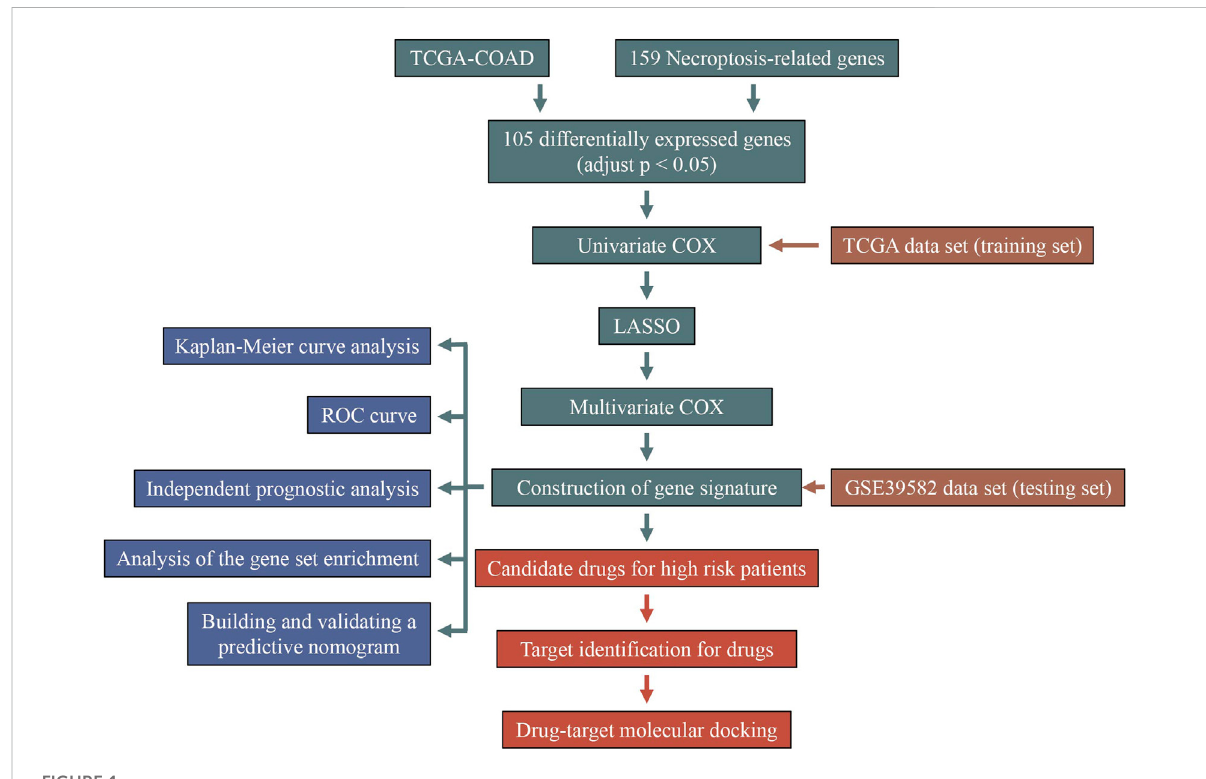
FIGURE 1 The fl ow chart of this